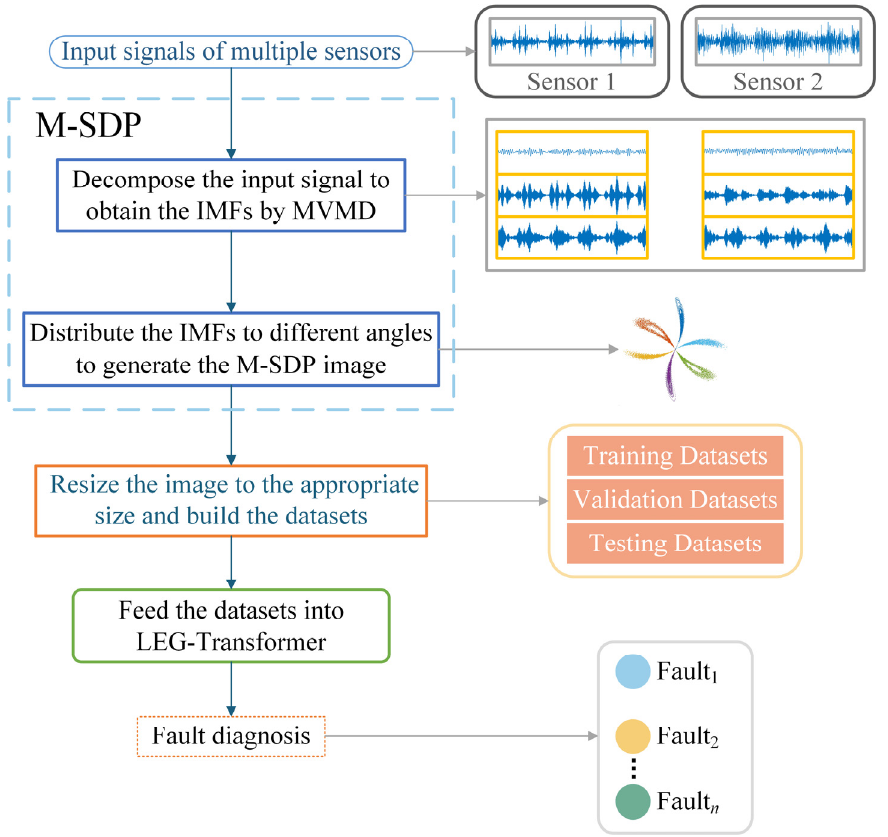
Figure 8. Procedure of bearing fault diagnosis based on M-SDP and the LEG Transformer.